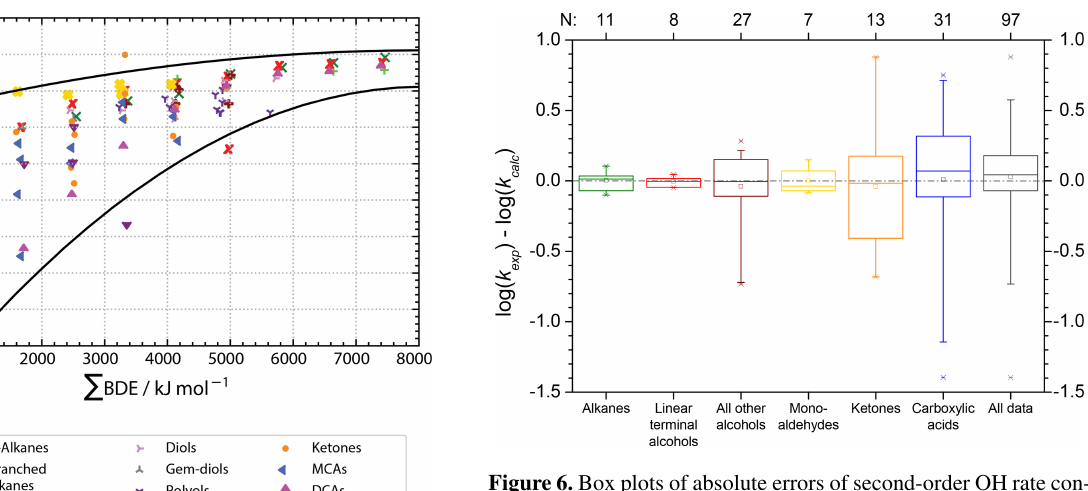
Figure 6. Box plots of absolute errors of second-order OH rate con- stants predicted with the advanced Evans–Polanyi-type correlations versus experimental data for the various compound classes as well as all